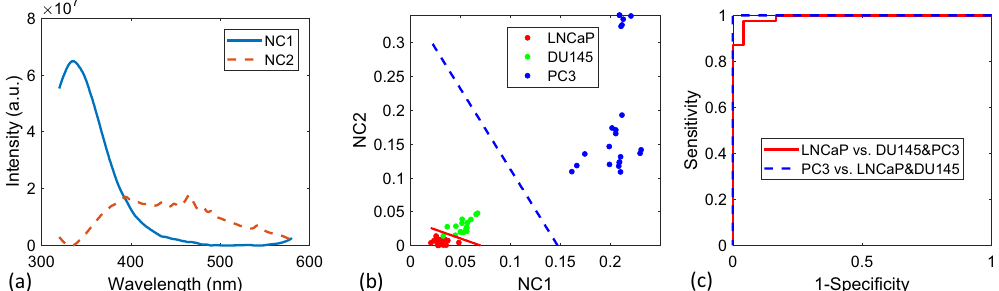
Figure 5. ( a ) Overlay of the first two extracted NMF feature spectra (solid and dashed corresponding to 1st and 2nd respectively). ( b ) Scatterplot of the corresponding NMF-related weight values for each NFL spectrum. The solid line separates the least advanced cell line (LNCaP) from the more advanced (DU145 and PC-3) and the dashed line shows the SVM boundary between the cell line possessing highest aggression (PC-3) and the two lowest (LNCaP and DU145). ( c ) The corresponding ROC curves for classification with LOOCV.